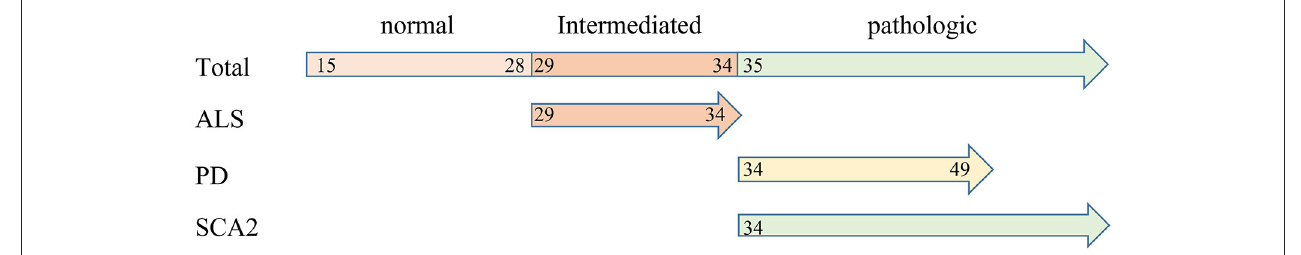
FIGURE 4 | The spectrum of diseases associated with ATXN2 polyQ repeat